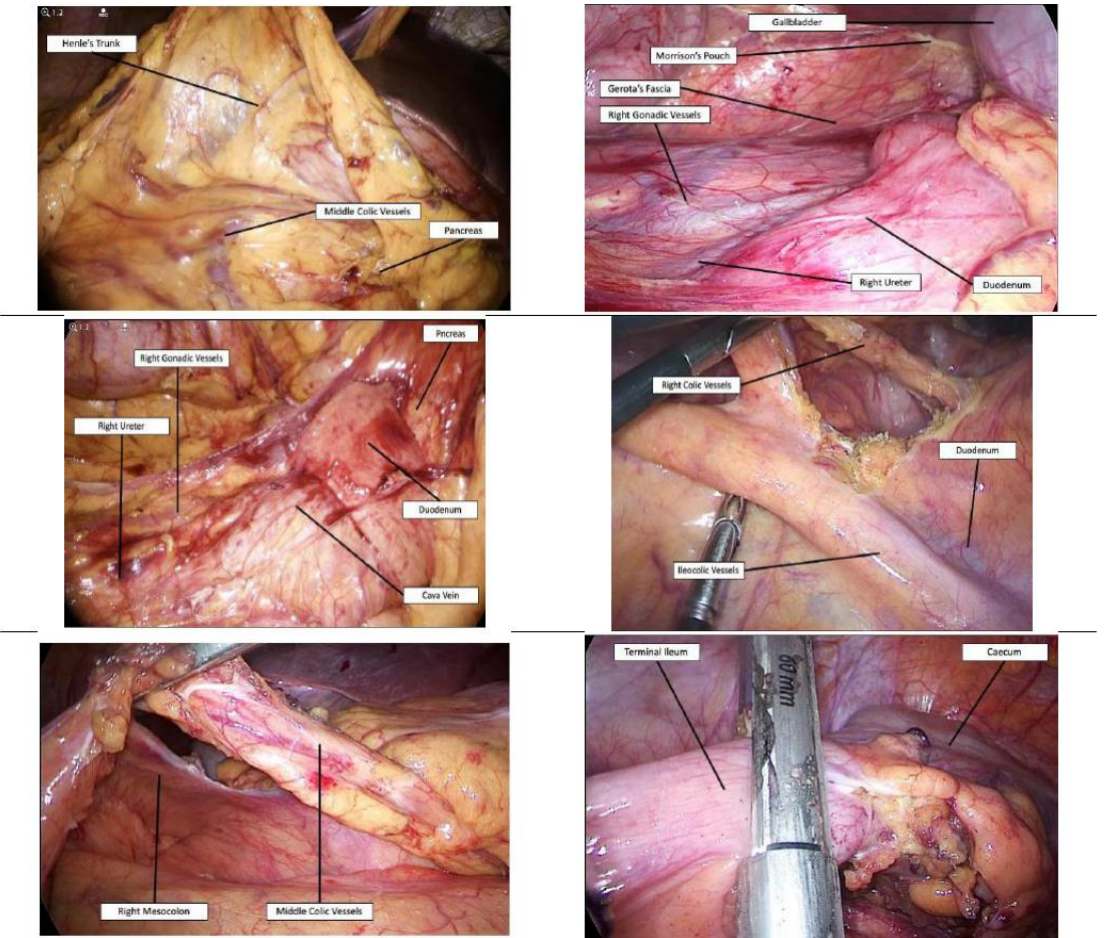
Figure 2. Upper panel: Critical-view VI (left) and VII (right). Middle panel: Critical-view VIII (left) and IX (right). Lower panel: Critical-view X (left) and terminal ileum division